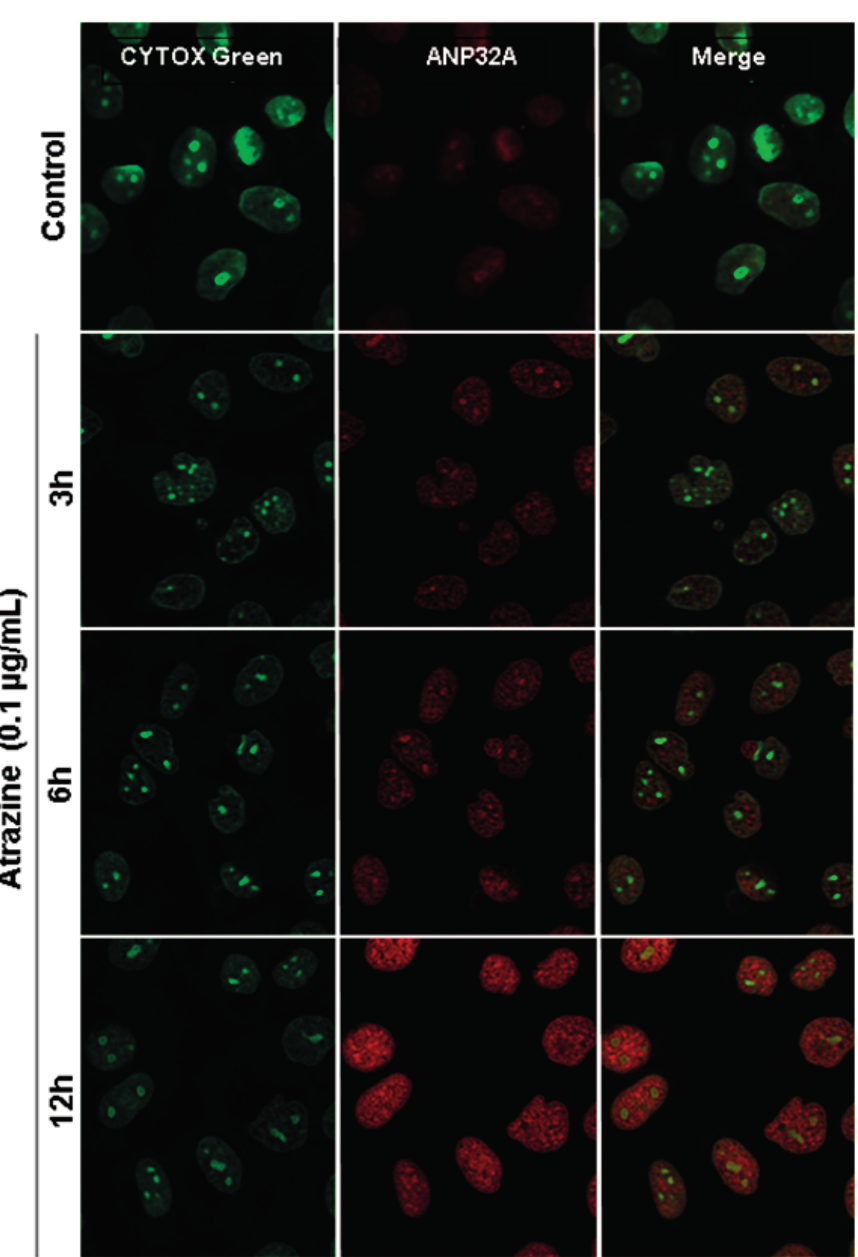
Figure 4. Subcellular localization of ANP32A in MCF-10A cells treated with 0.1 µg/mL atrazine for the indicated time periods. ANP32A antibody was indirectly labeled with Alexa Fluor 568 secondary antibody (red) and cells were mounted with ProLong Gold anti-fade with SYTOX Green nucleic acid stain (green). All images were captured using a Carl Zeiss confocal microscope with the same exposure